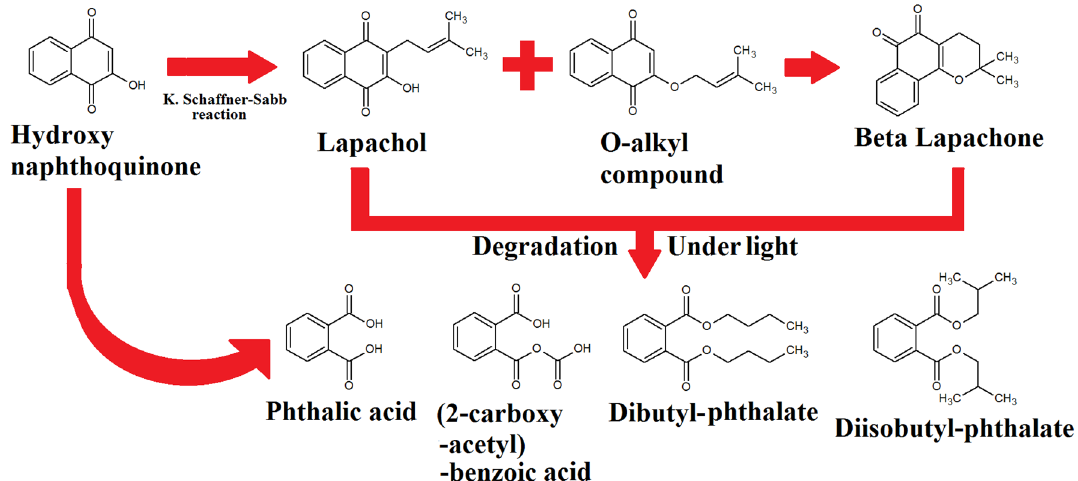
Figure 6. Lapachol, β-lapachone and the phthalates can all be synthesised directly from naphthoquinones. Under light conditions, the phthalates may also arise from lapachol and β-lapachone